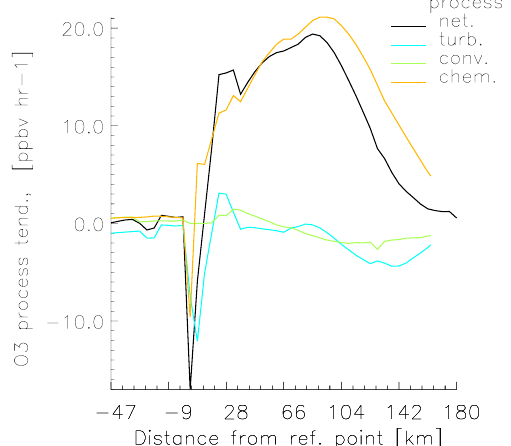
Fig. 18. Simulated ozone production/destruction rates in the “power plant” plume at 400m altitude. The legends turb (cyan line), conv (green line), and chem (orange line) refer to the turbulent, convec- tive and chemical tendencies, respectively, which together make up the total net tendency in O 3 processes, referred to as net (black line).